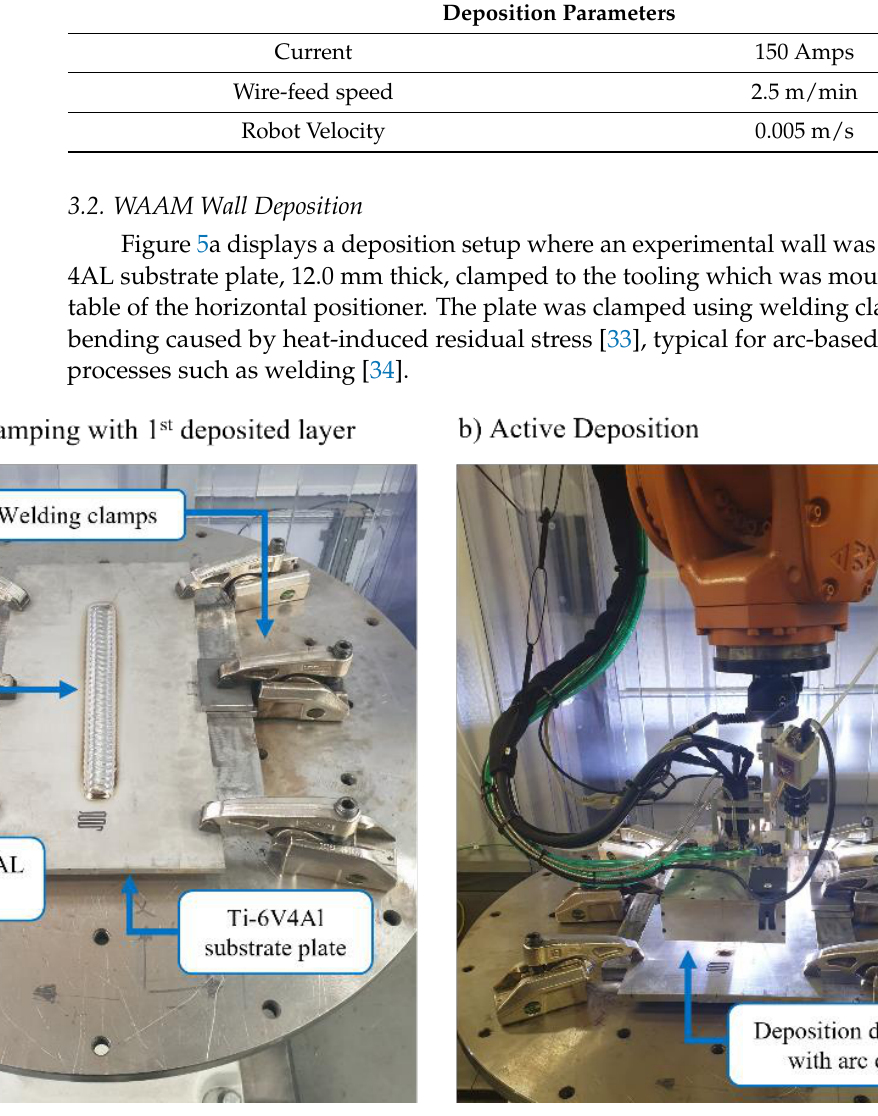
Figure 5. Deposition clamping setup and a substrate plate with a deposited 1st layer ( a ) and